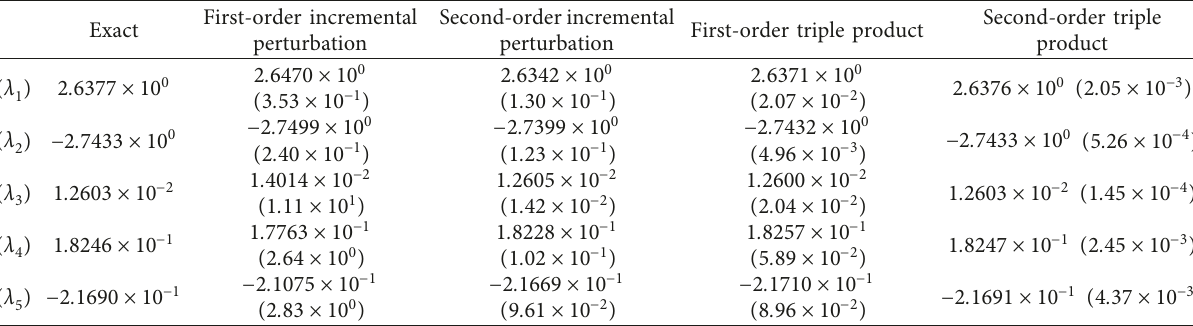
0 . 5. (cid:31) 7 for σ 0 . 5. (cid:31) (cid:31)